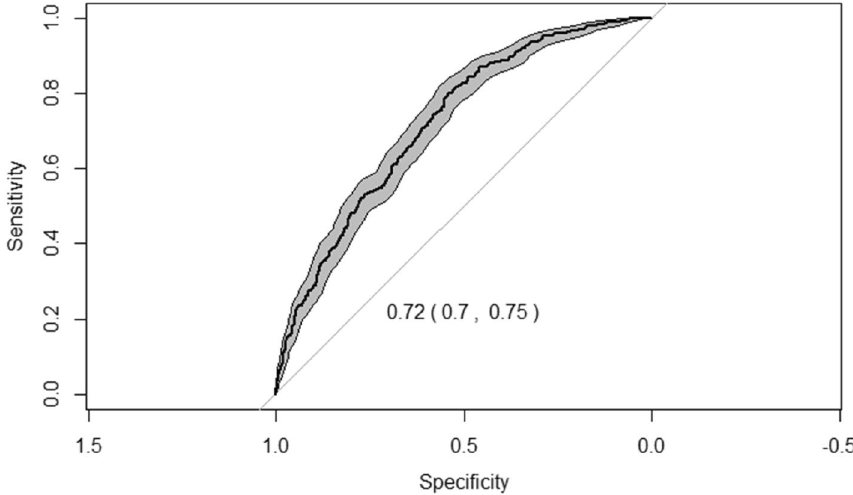
Figure 2. Area under the curve showing the reliability of the CHRONIBERIA index when applied to the global sample.